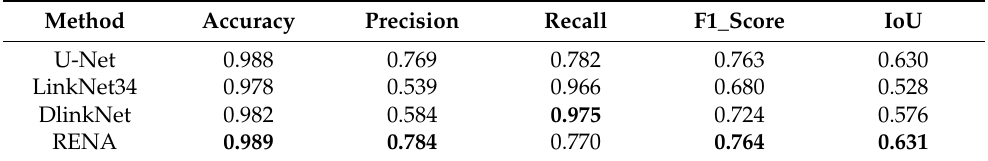
Table 2. Quantitative evaluation results.